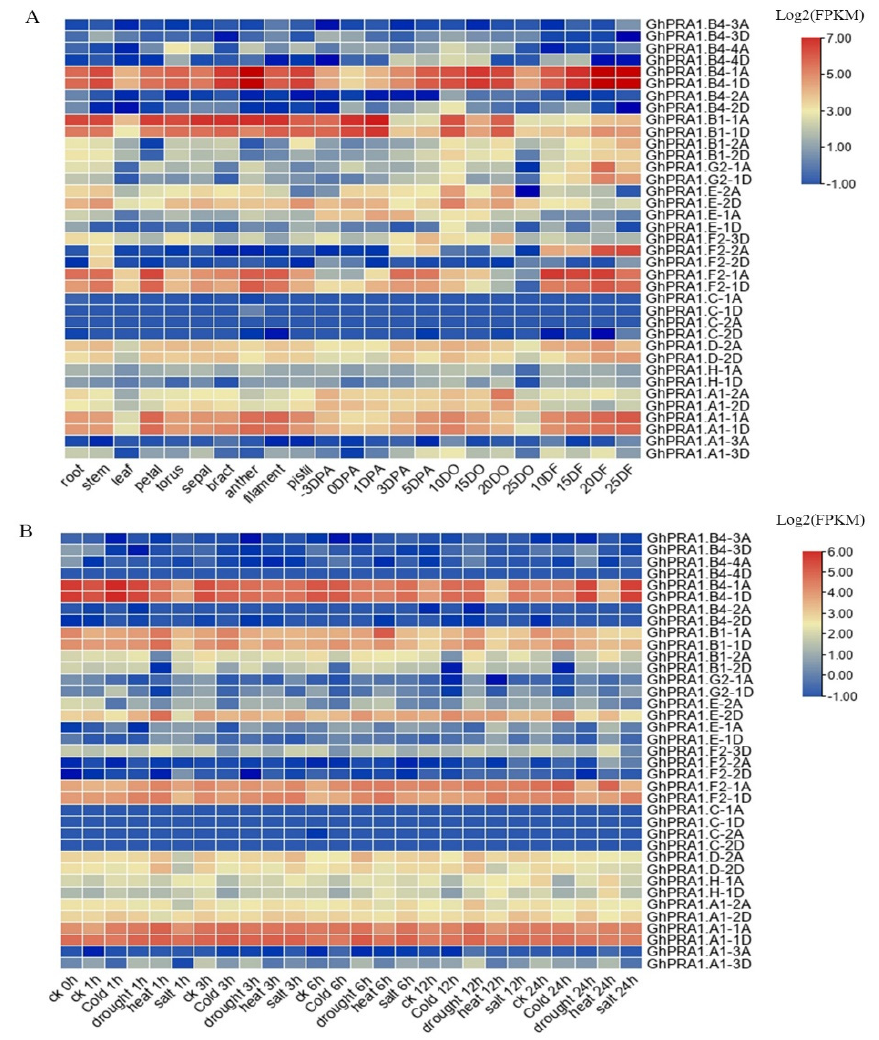
Figure 5. Expression patterns of GhPRA1 genes in different tissues under abiotic stress in upland cotton. ( A ) The expression profiles of GhPRA1 genes in cotton tissue. DO and DF represent DPA ovules and fibers, respectively. ( B ) The expression profiles of GhPRA1 genes under abiotic stress.